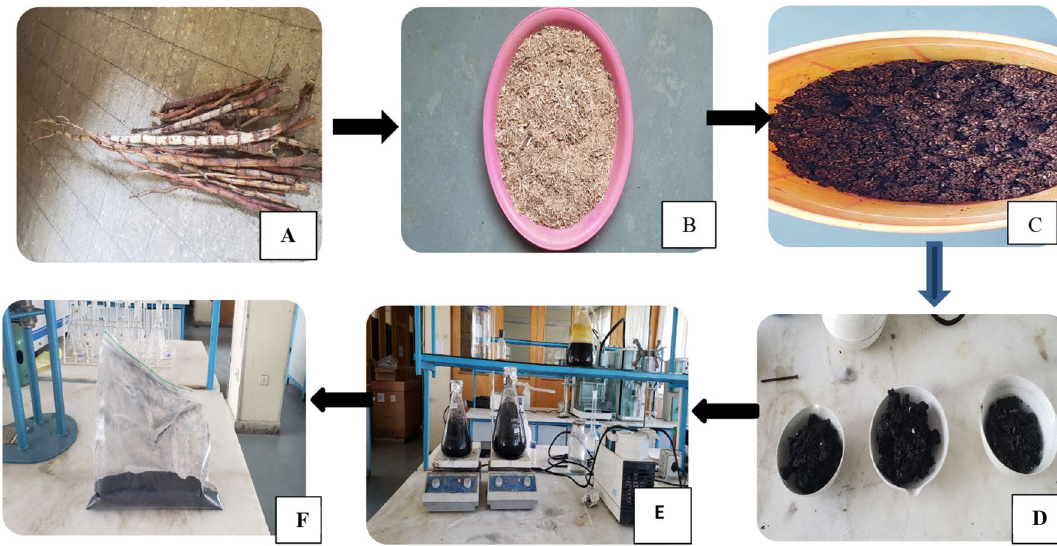
Figure 1. HYPERLINK "sps:id::fig1||locator::gr1||MediaObject::0" Different preparation stages of activated carbon from Rumex